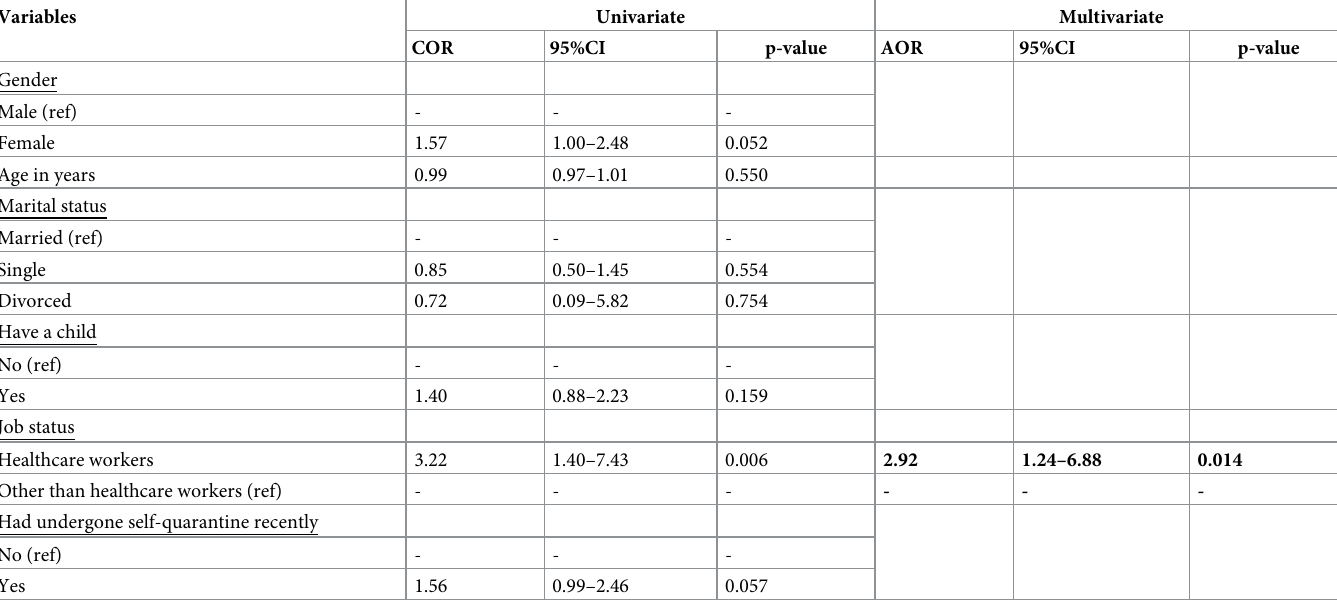
Table 5. Univariate and multivariate logistic regression analysis for